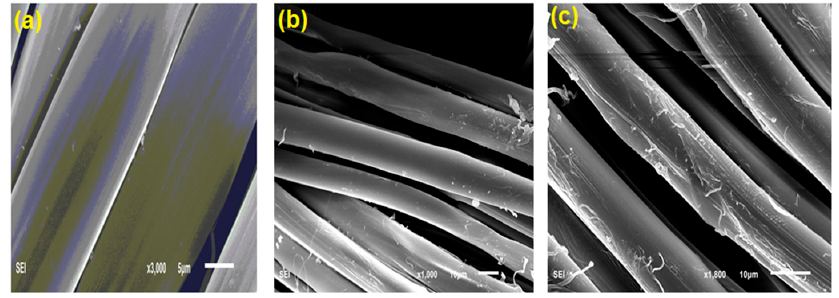
Figure 6. SEM micrographs of ( a ) control silk and silk treated at ( b ) 35 ppm and ( c ) 70 ppm AgNPs.